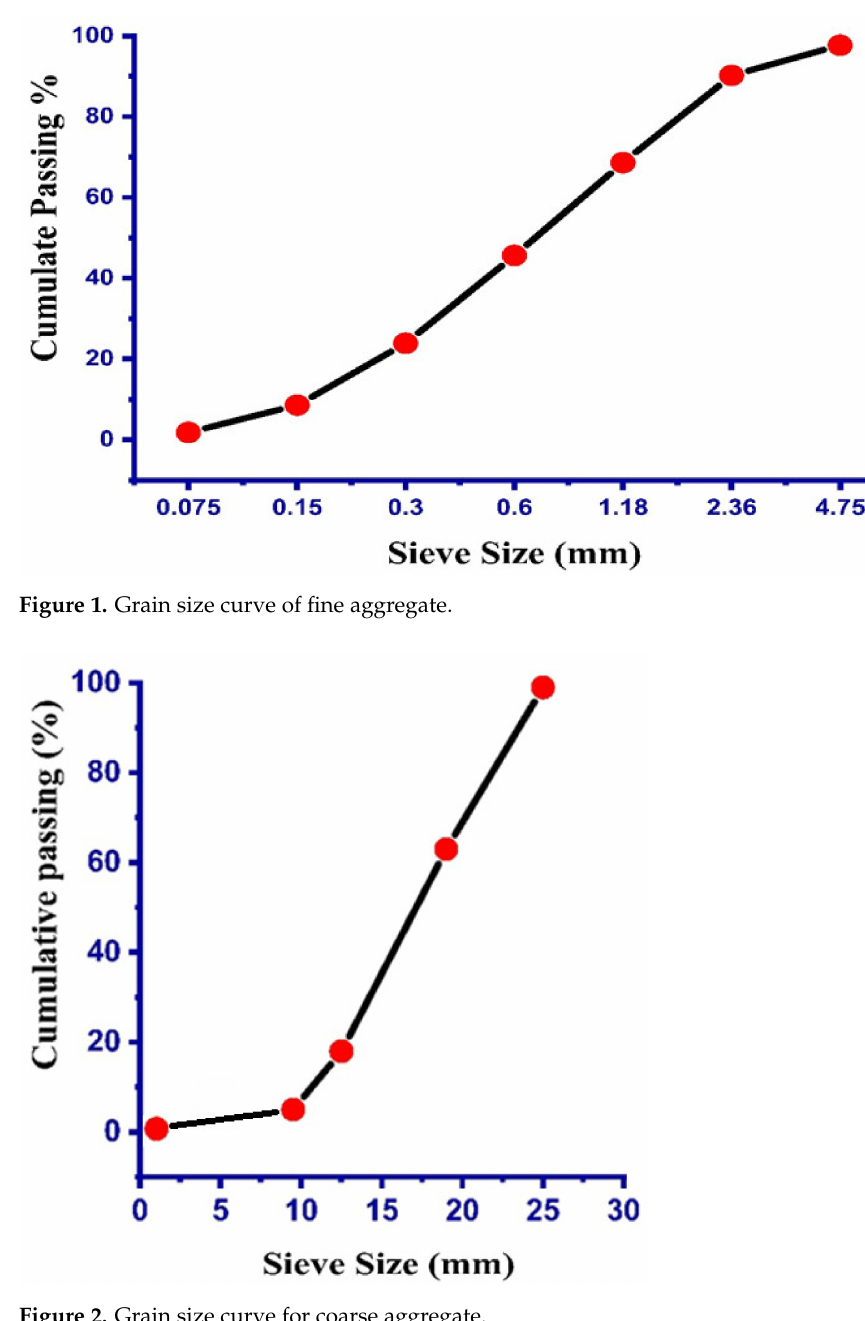
Figure 2. Grain size curve for coarse